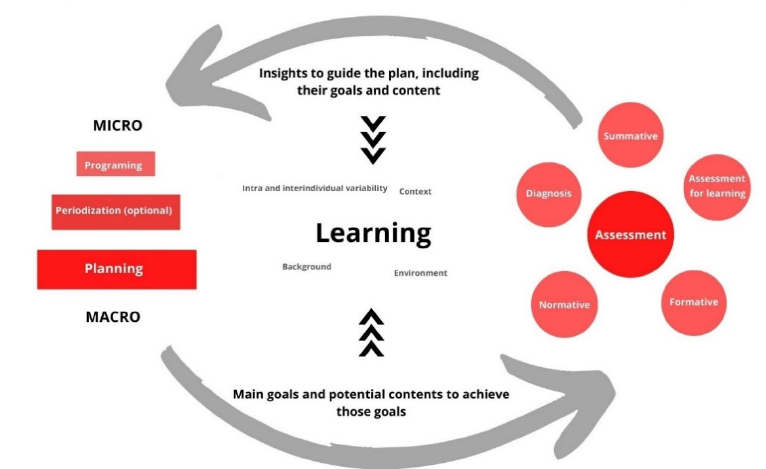
Figure 1. Ongoing feedback between assessment and planning.